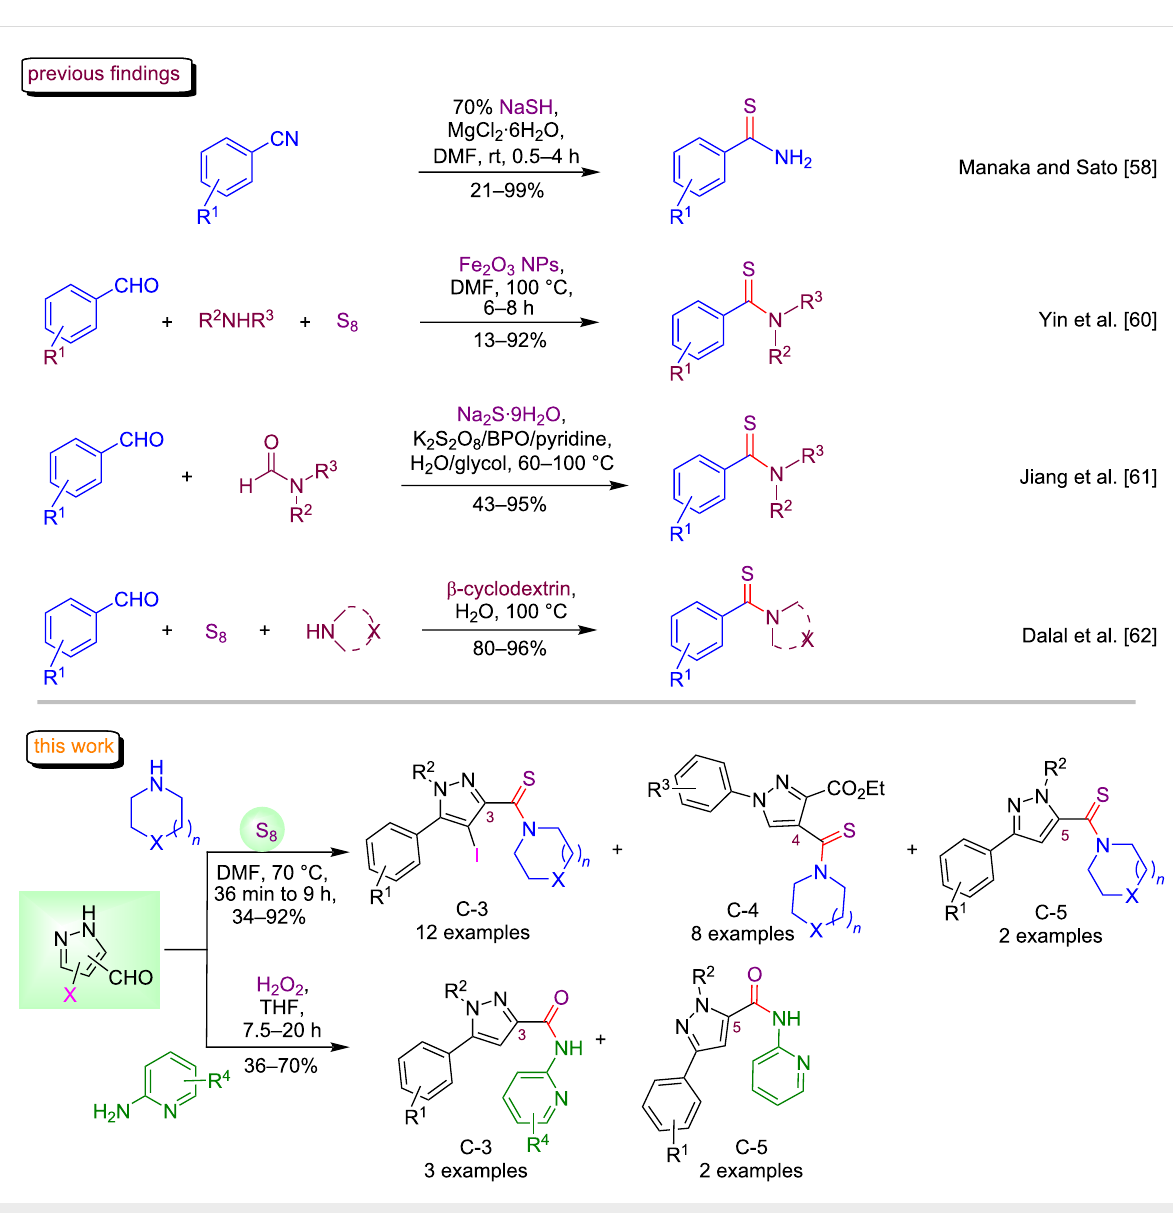
tions were inactive towards the formation of